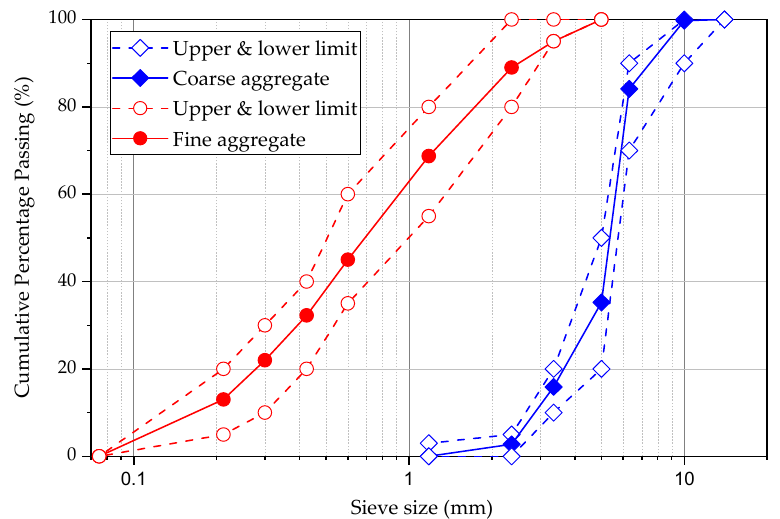
Figure 1. Sieve analysis data of coarse and fine aggregates.